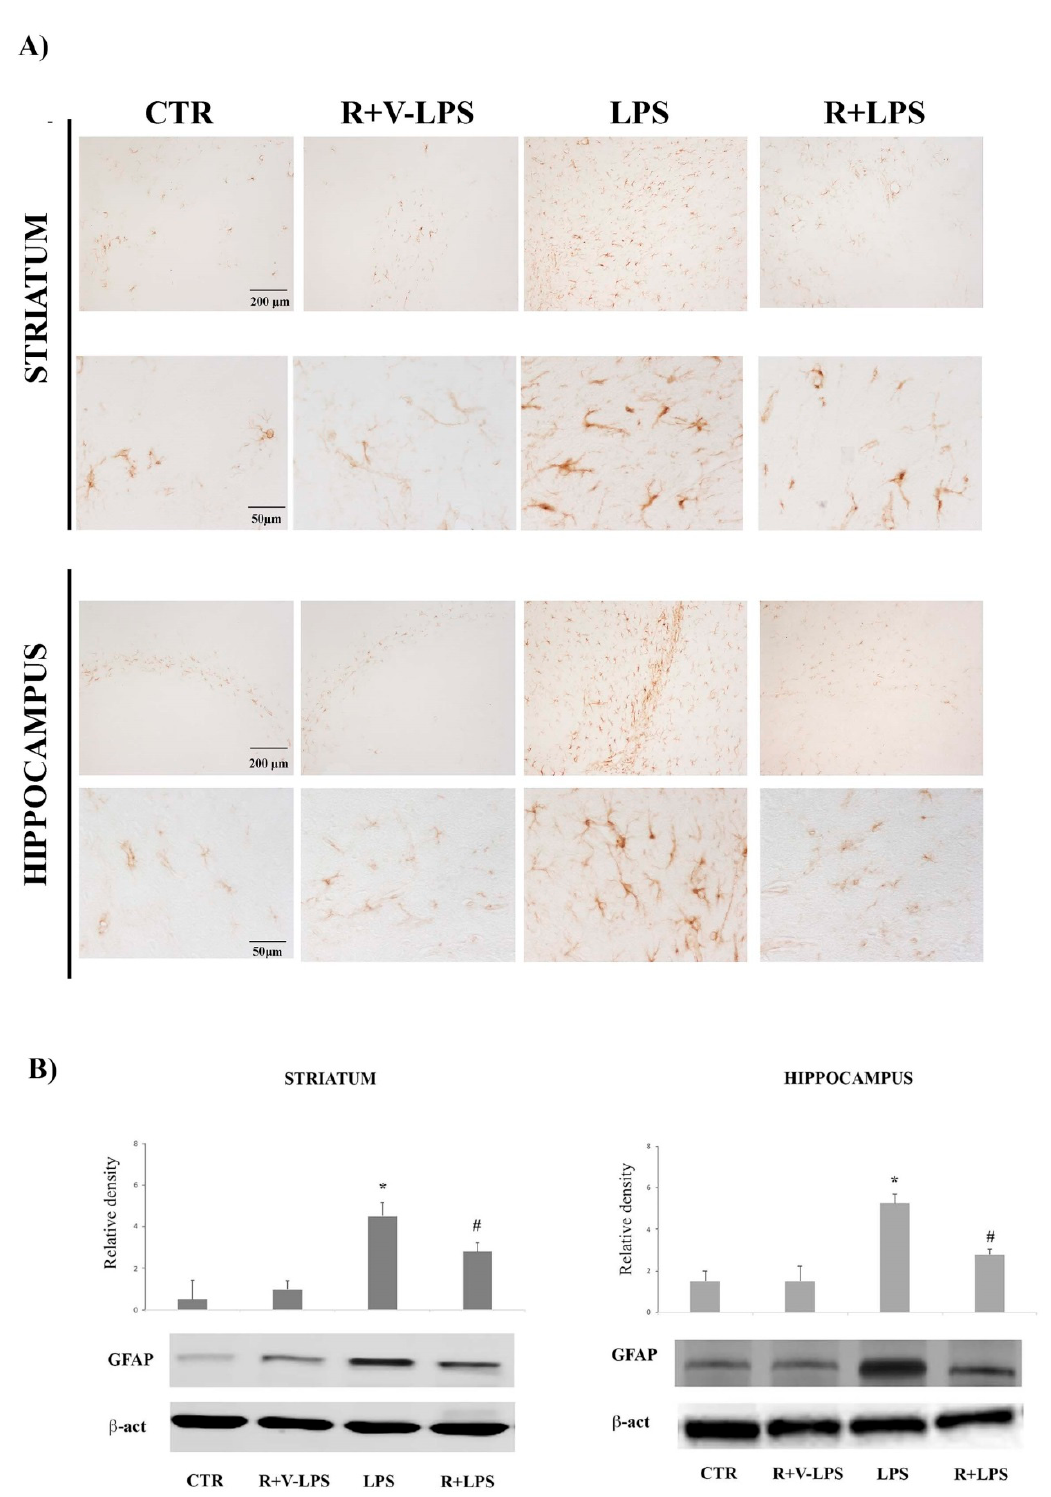
Figure 1. ( A ) GFAP immunoreactivity in the striatum (upper) and hippocampus (lower) in untreated controls mice (CTR), mice treated with resveratrol and LPS vehicle (R+V-LPS), LPS-treated mice (LPS) and resveratrol plus LPS treated mice (R+LPS). ( B ) Western blotting detection and densitometric analysis of GFAP expression levels in untreated controls mice (CTR), mice treated with resveratrol and LPS vehicle (R+V-LPS), LPS-treated mice (LPS) and resveratrol plus LPS treated mice (R+LPS) in the striatum (left) and hippocampus (right). For GFAP protein expression analysis values are expressed as arbitrary units after normalization against β -actin, used as a loading control. Data are represented by mean ± SD ( n = 5 in each group, 5 replicates). * p < 0.05 vs. control; # p < 0.05 vs. LPS.